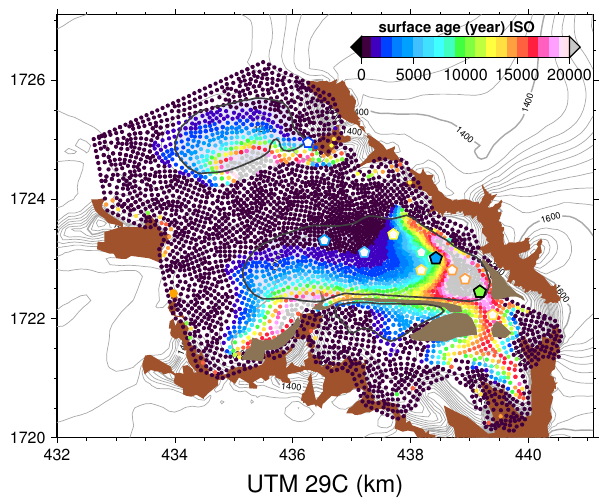
Fig. 5. Age (dots – scale bar) distribution obtained with the isotropic Glen’s flow law and a 15kyr integration of the age equation com- pared to measured (pentagons). Solid lines enclose